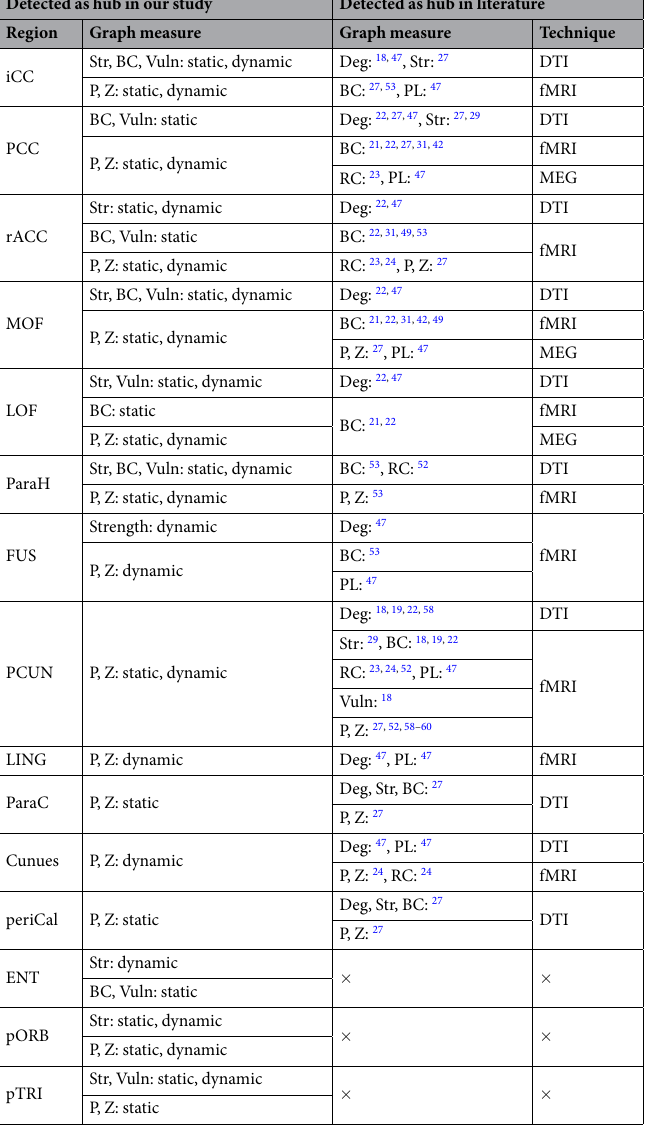
Table 1. A comparison between the identified brain hubs in our study with structural and functional previous studies. Abbreviations. Deg: degree, Str: strength, PL: path length, BC: betweenness centrality, P: participation coefficient, Z: within degree module and Vuln: